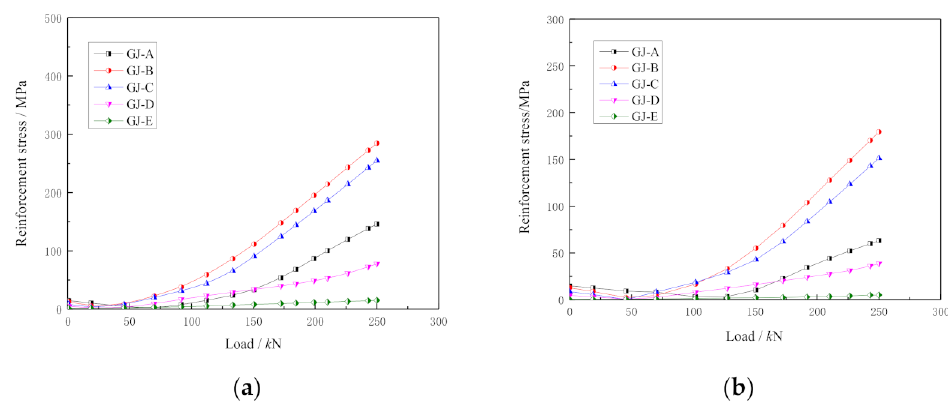
Figure 16. GD2 specimen: ( a ) No. 1 steel bar and ( b ) No. 2 steel